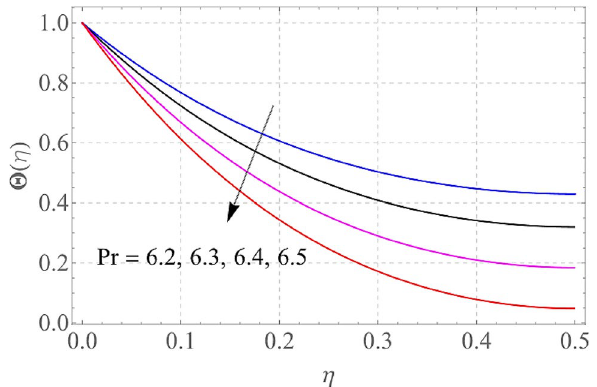
Figure 9. Alterations in �(η) as Pr raises. When M = S = 0.1, Gc = 0.2, Ec = 1, Nb = Nt = 0.3, Sc = 0.3 .